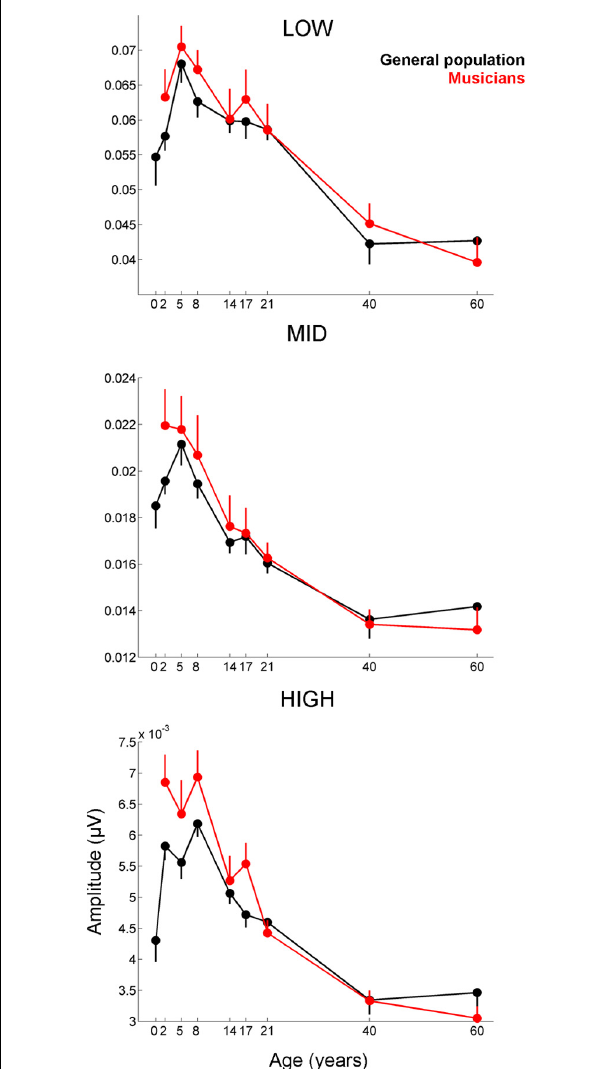
FIGURE 4 | Developmental trajectories for the low-, mid-, and high-frequency components of the frequency-following response of the cABR are plotted for the musicians (red) and general population (black). Error bars represent one standard error of the mean (mean − 1 S.E. for the general population and mean + 1 S.E. for the musicians). The value reported on the x-axis represents the youngest age for each group, e.g., 5 represents 5–8and8represents8–14.Theinfantgroupwasnotfactoredintotheanalysis but is plotted here for reference. In all three frequency bands, the response amplitude peaks during early school age years, (i.e., the 5–8 and 8–14 age ranges).Amaineffectofgroupwasfoundforthehigh-frequencyregionofthe response ( p < 0 . 014), with the largest differences between the musicians and general population appearing during childhood when the developmental trajectory is cresting. Similar patterns are observed for the other frequency ranges although the statistics are not significant.